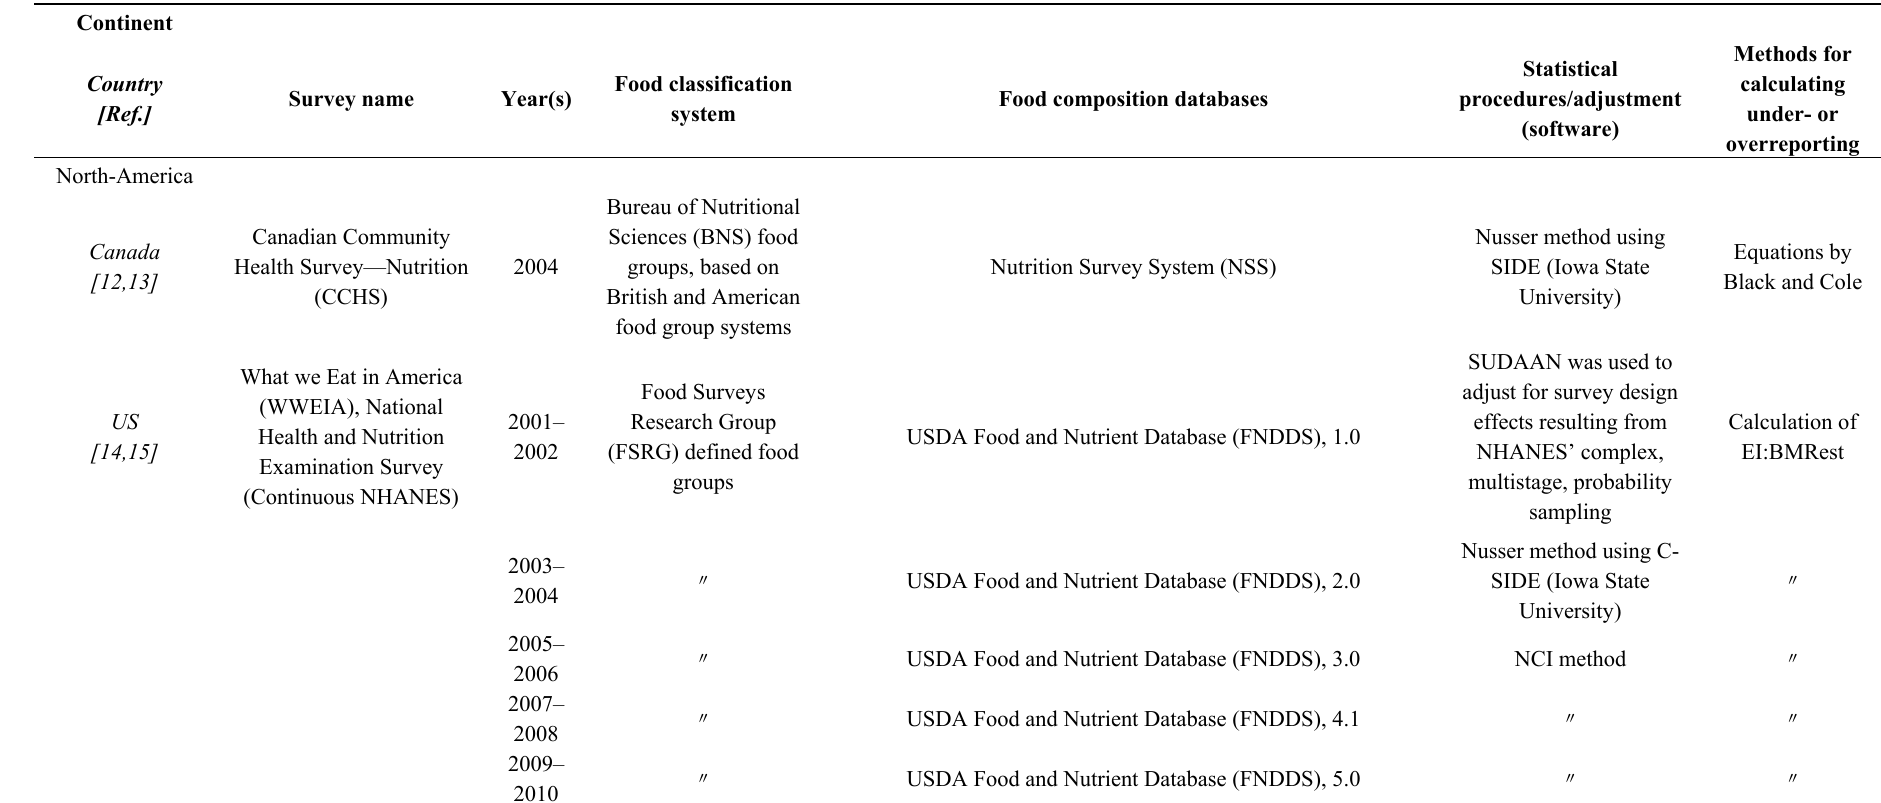
Table 6. Food linking and analysis of national nutrition surveys per